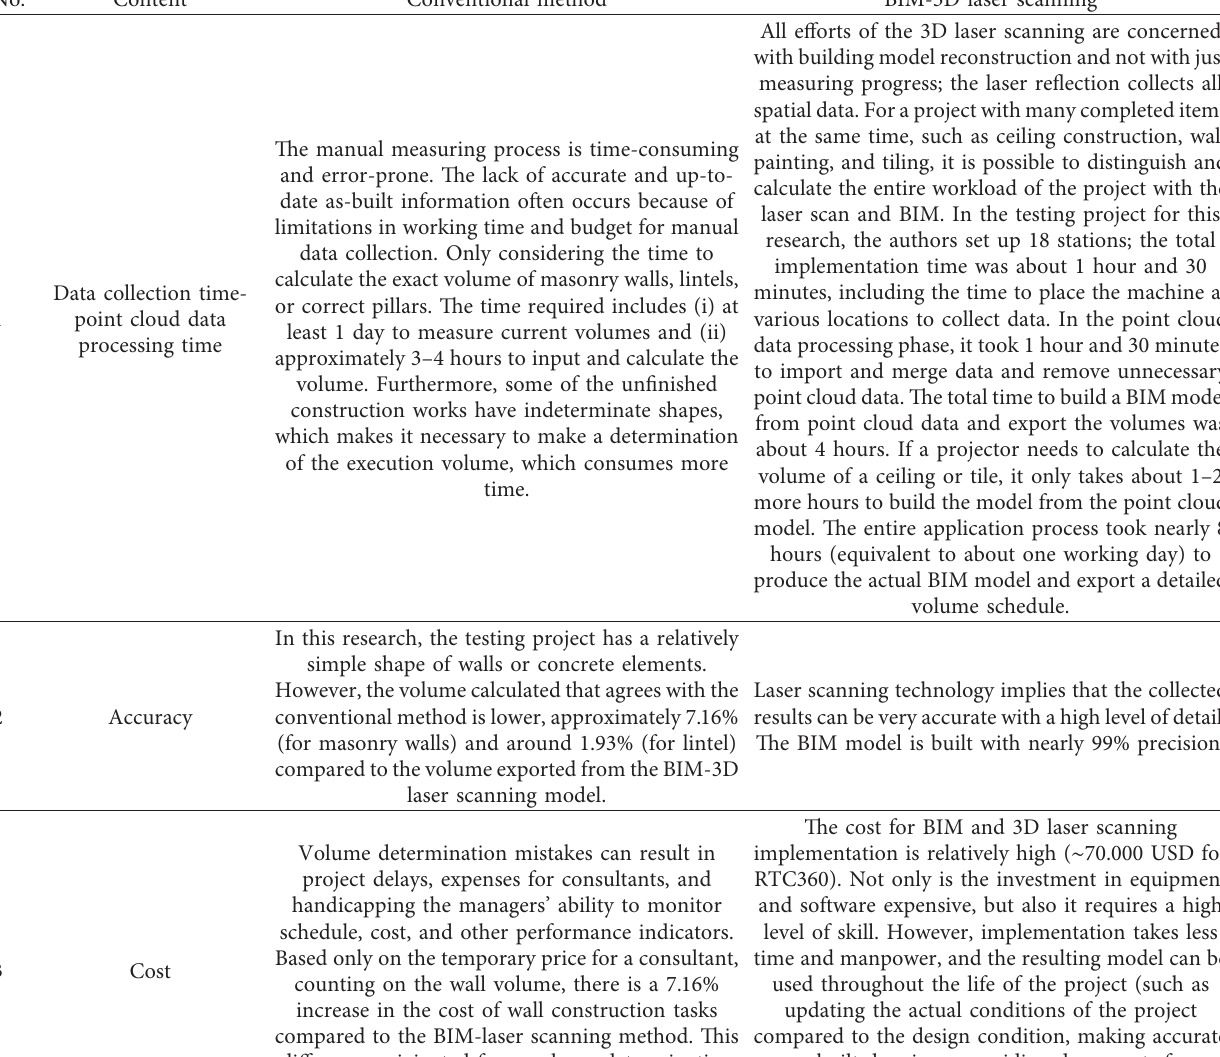
Table 1: Evaluation and comparison between the conventional method and BIM-3D laser scanning method. No. Content